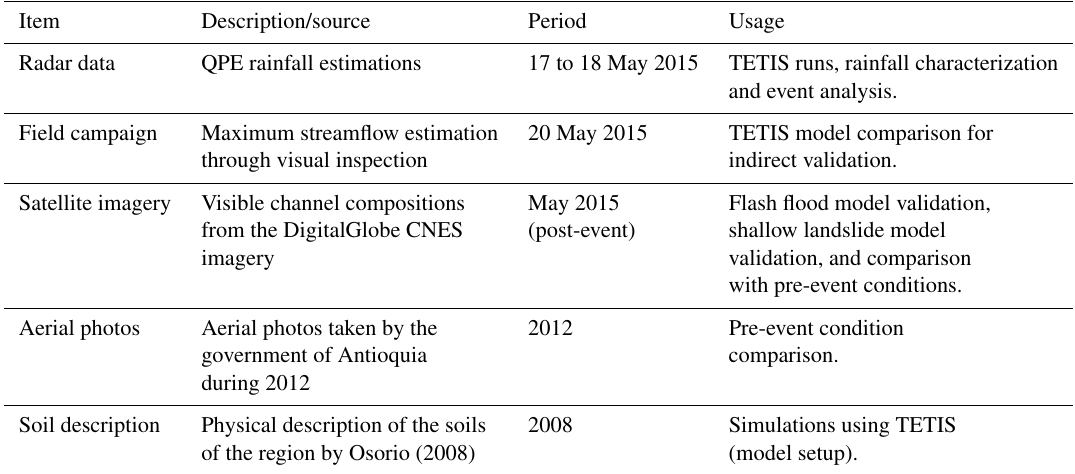
Table 2. Summary of the data used for the setup of